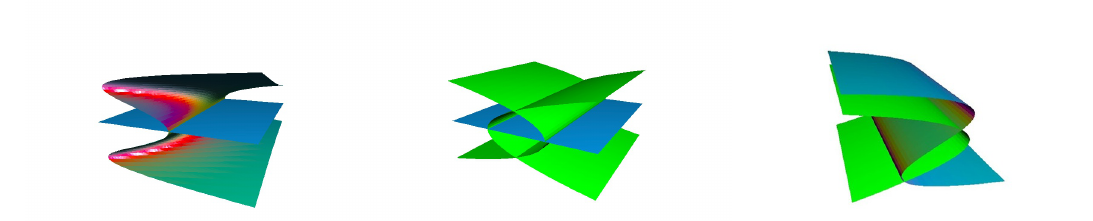
Figure 11 . Reducible degree five spectral covers with smooth